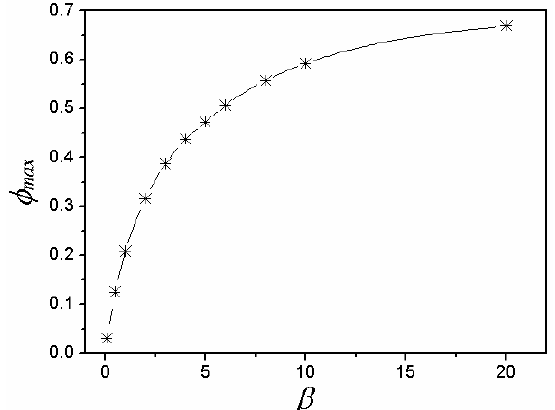
Figure 3. Relationship between the Biot number, β , and the maximum value of stress reduction factor, φ . max